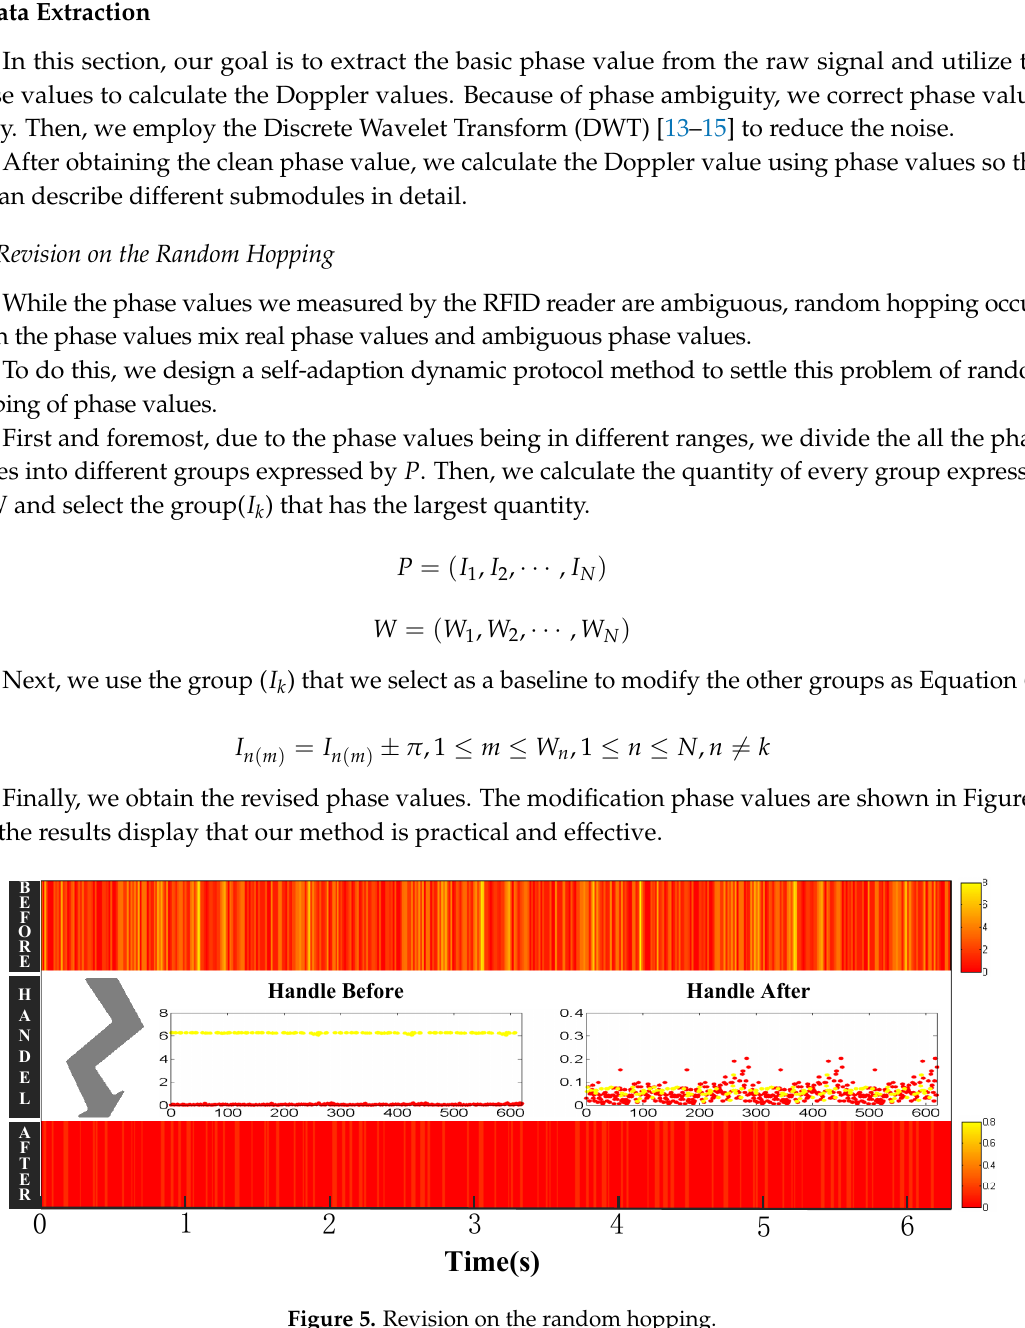
Figure 5. Revision on the random